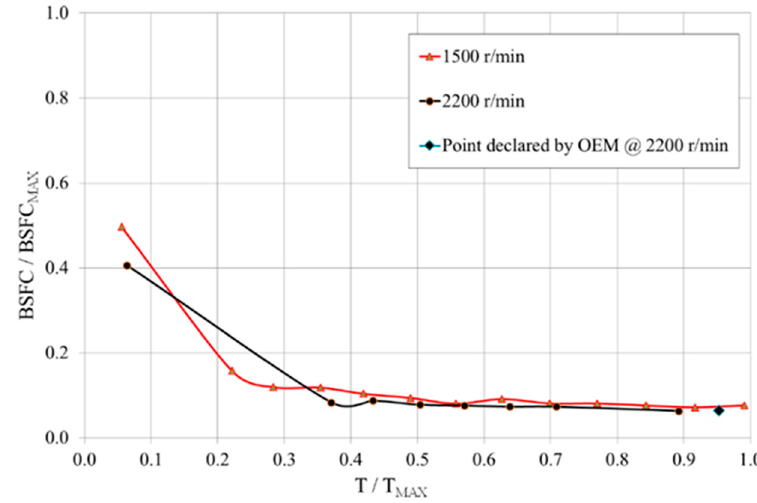
Figure 3. Diesel engine—brake specific fuel consumption map.